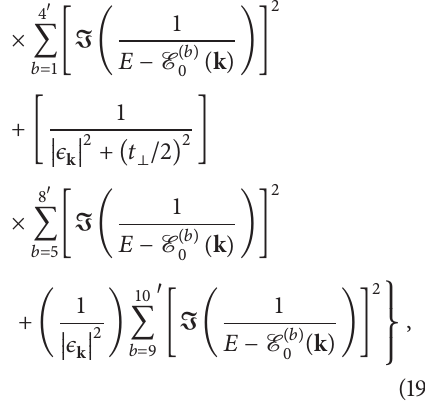
󸀠 implies sum over just